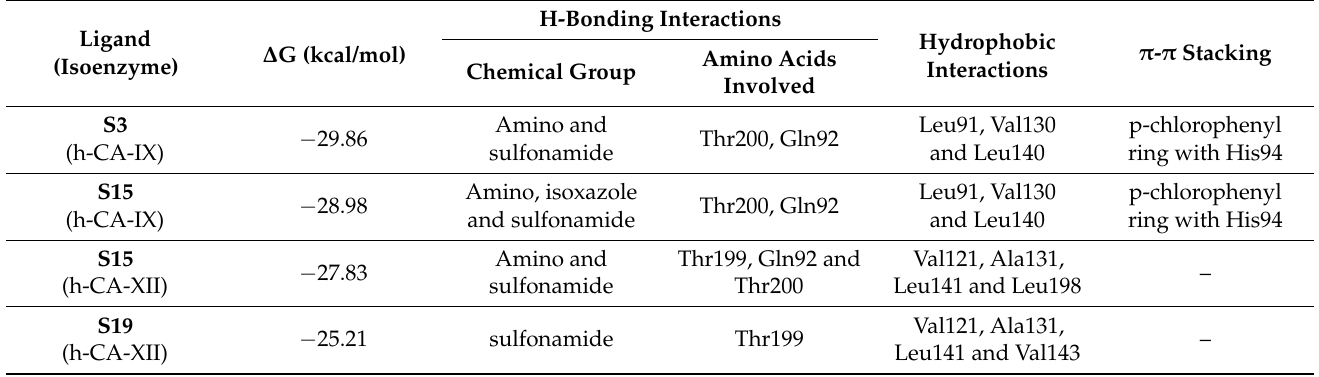
Figure 7. ( A ) ligand (9FK, green) co-crystallized and its redocked pose (yellow) inside the active place of h CA IX isoenzyme (PDB code: 5FL4); ( B ) Alignment of the top docked poses of compounds S3 (cyan), S15 (yellow) and 9FK (green) as a co-crystalized ligand into the binding pocket of h CA IX isoenzyme (PDB code: 5FL4); ( C ) Alignment of the top docked poses of compounds S3 (cyan), S15 (yellow), S19 (violet) and acetazolamide (green) as a co-crystalized ligand into the binding site of hCA-XII isoenzyme (PDB code: 1JD0). The protein structures were displayed as solvent surfaces colored by atom charge. Table 5. The collective docking results and the interactions of compounds S3 and S15 into h -CA-IX isoenzyme and S15 and S19 into h -CA-XII